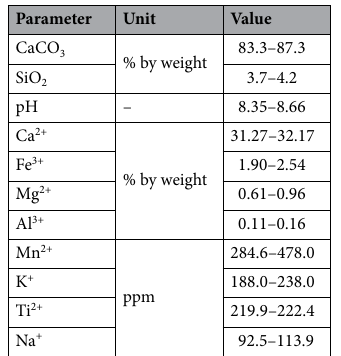
Table 1. Chemical composition of lime-softening sludge 12 . 1 ppm = 1 mg/1 kg, 1% = 10,000 ppm.